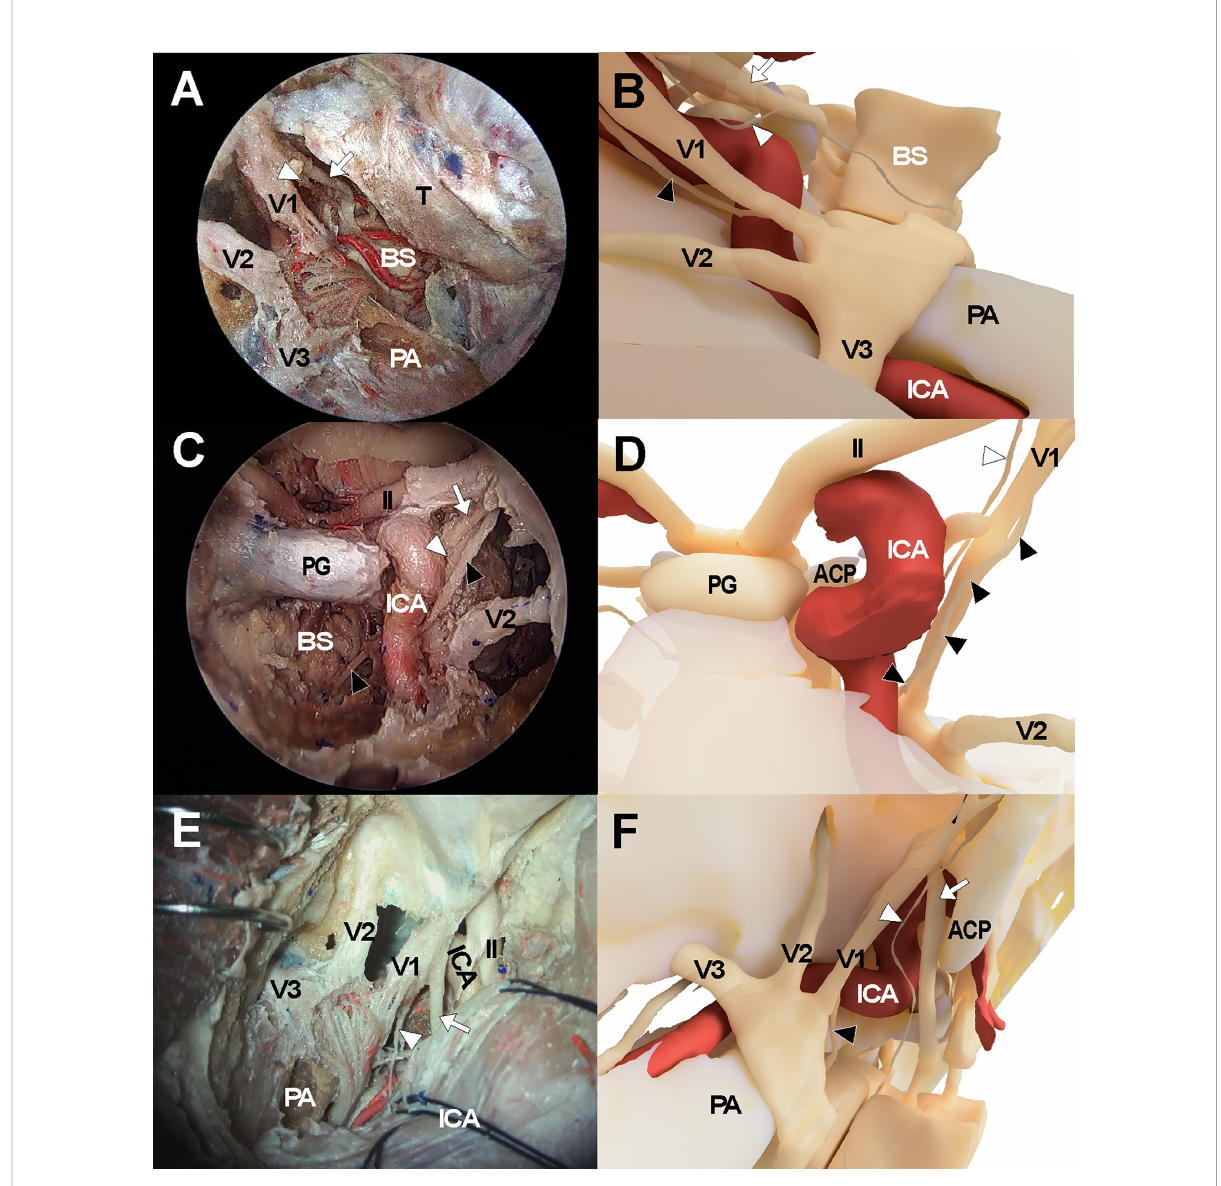
FIGURE 3 Cadaveric views and three-dimensional illustrations for cavernous sinus and surrounding neurovascular structures in the comparison with endoscopic transorbital approach (A, B) , endoscopic endonasal approach (C, D) , and transcranial approach (E, F) . The white arrows indicate oculomotor nerve while the white arrowheads and black arrowheads indicate trochlear nerve and abducens nerve, respectively. ACP, anterior clinoid process; ICA, internal carotid artery; II, optic nerve; PA, petrous apex; PG, pituitary gland; V1, ophthalmic branch of trigeminal nerve; V2, maxillary branch of trigeminal nerve; V3, mandibular branch of trigeminal